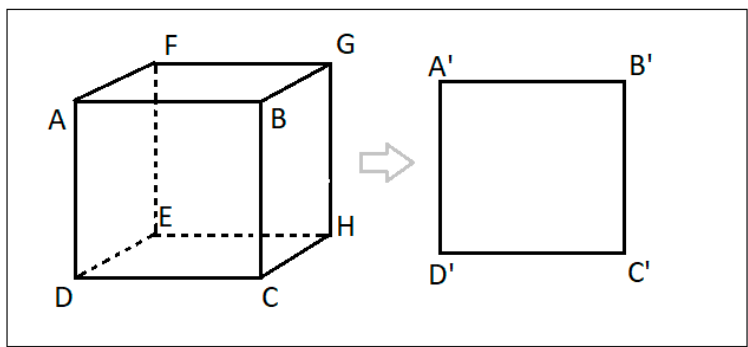
Figure 9. 3D object bounding box as projected into corresponding 2D space. Executing Fusion Node—OSCF and